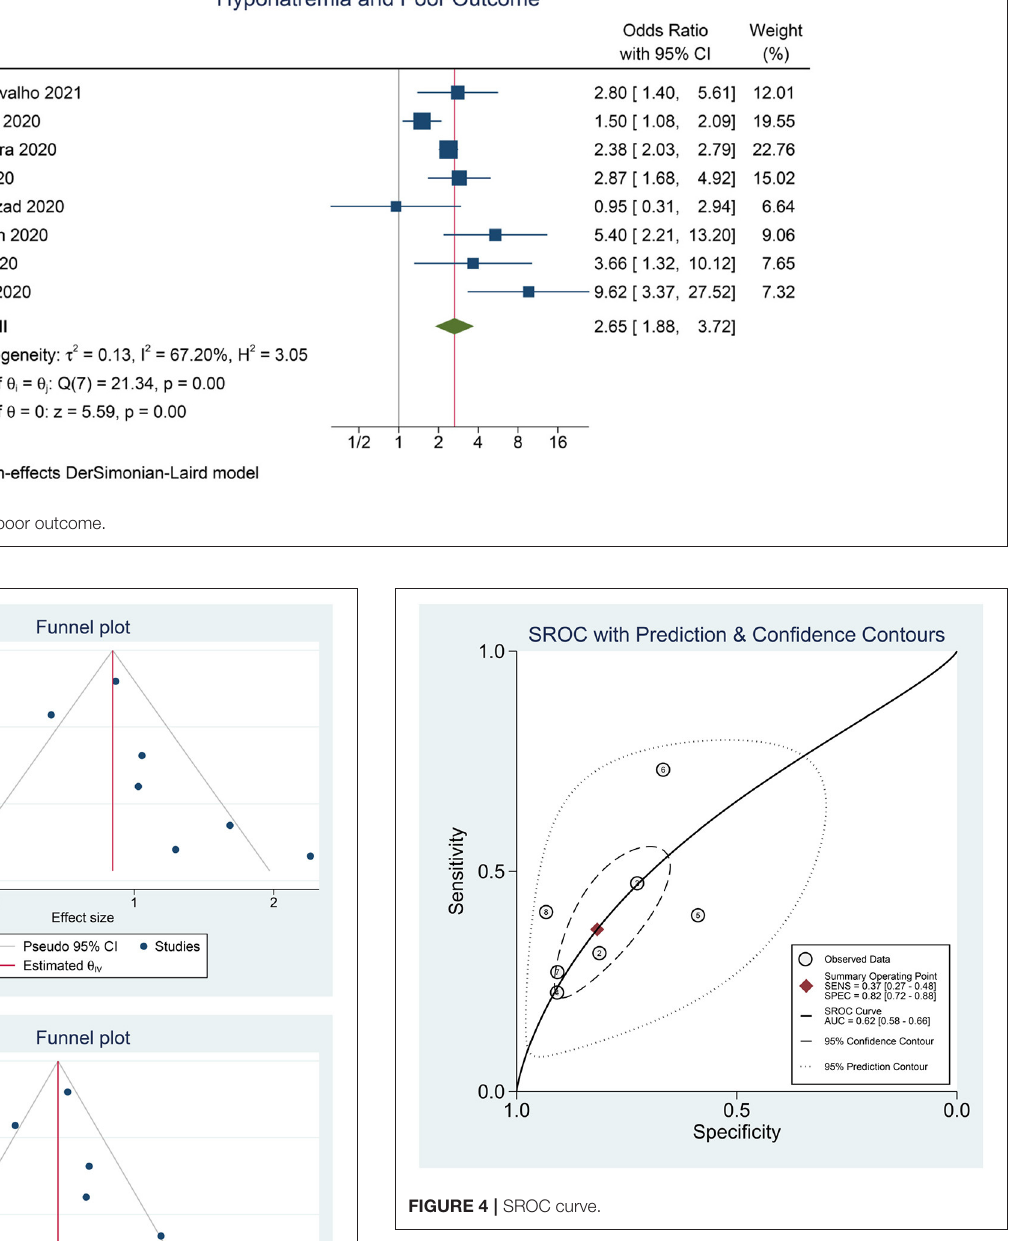
( Figure 3B ). There is no indication for small-study effects ( p = 0.231). Meta-regression analysis showed that the association